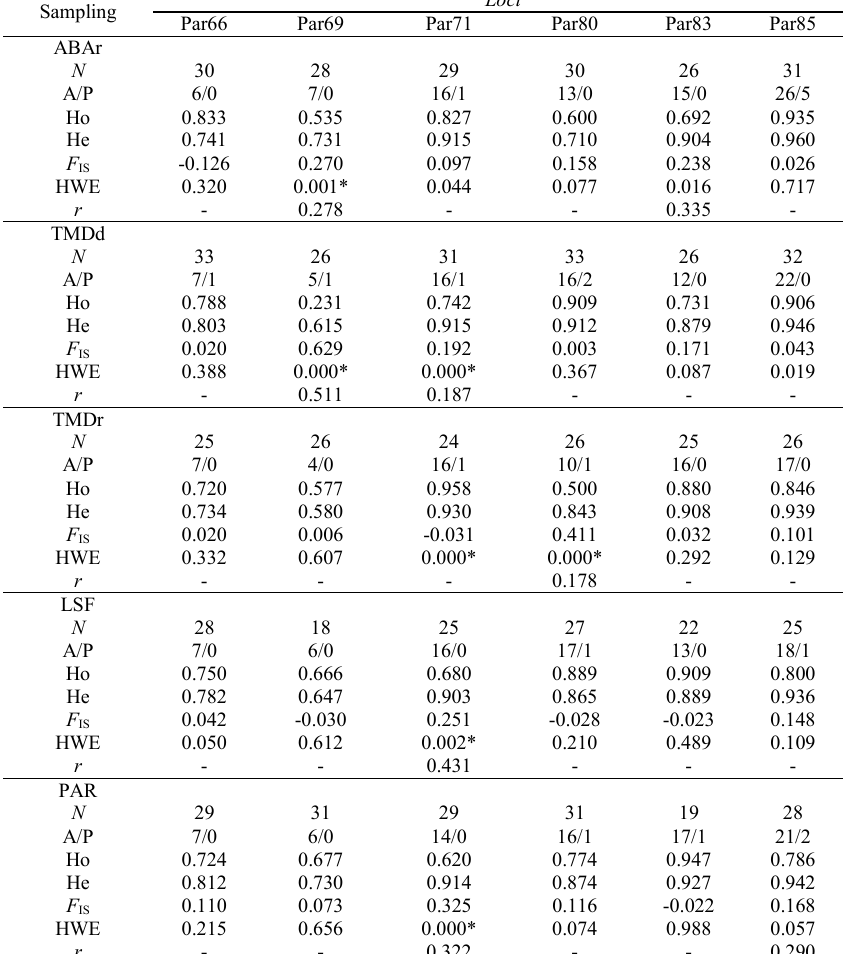
Table 6. Summary of the six microsatellite loci for each analyzed sampling of Prochilodus costatus . N, number of individuals; A, number of alleles; P, number of private alleles; Ho, observed heterozygosity; He, expected heterozygosity; F coefficient; HWE, probability test for deviation from expected Hardy-Weinberg proportions, *, P-value = 0.05 (adjustment Bonferroni correction P < 0.008; K = 6); r , null alleles frequency per loci . ABAr = rio Abaeté at rainy season; PAR = rio